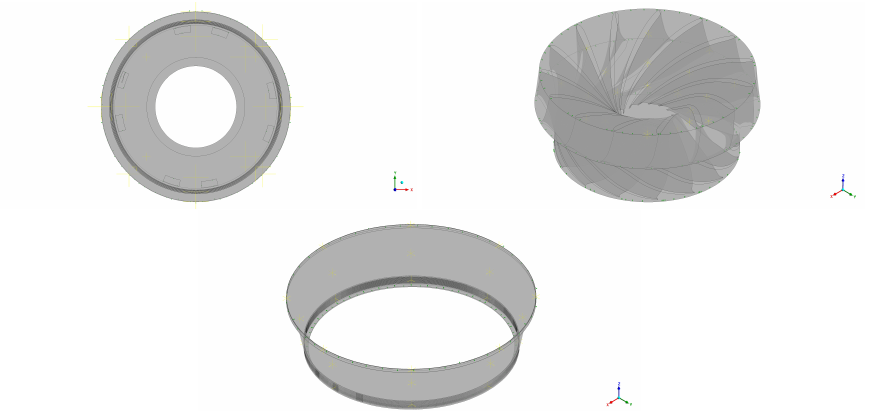
Figure 13. The monitoring points of the crown chamber ( top-left ), the runner ( top-right ), and the bottom ring chamber ( lower